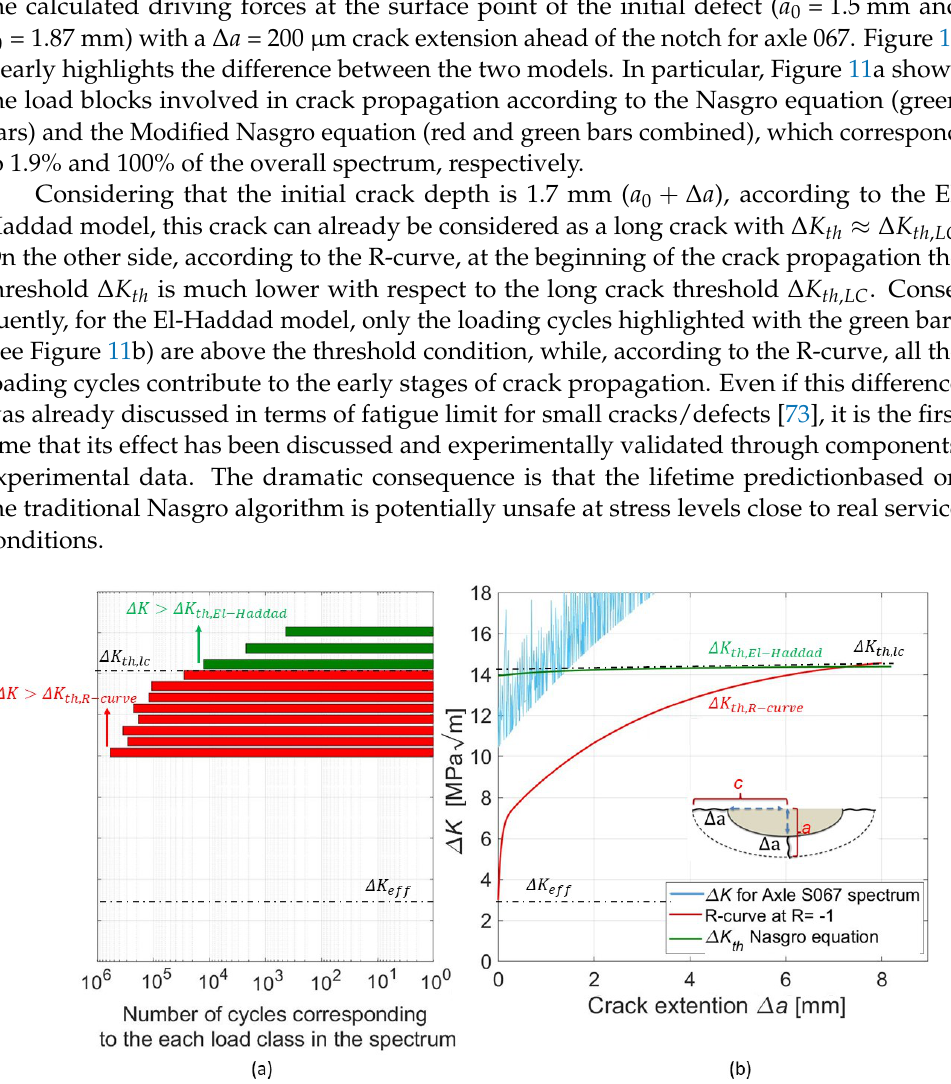
Figure 11. Comparison of the ∆ K th condition according to the Nasgro equation and Modified Nasgro equation (R-curve) for a initial crack size of a 0 = 1.5 and c = 1.85 mm with a ∆ a = 200 µ m crack extension ahead of the notch (Axle S067): ( a ) ∆ K levels and corresponding number of cycles in the spectrum and ( b ) The calculated driving forces ∆ K in the surface point of the crack plotted against the threshold condition adopted in Modified nasgro equation and Nasgro equation (El-hadad correction for short